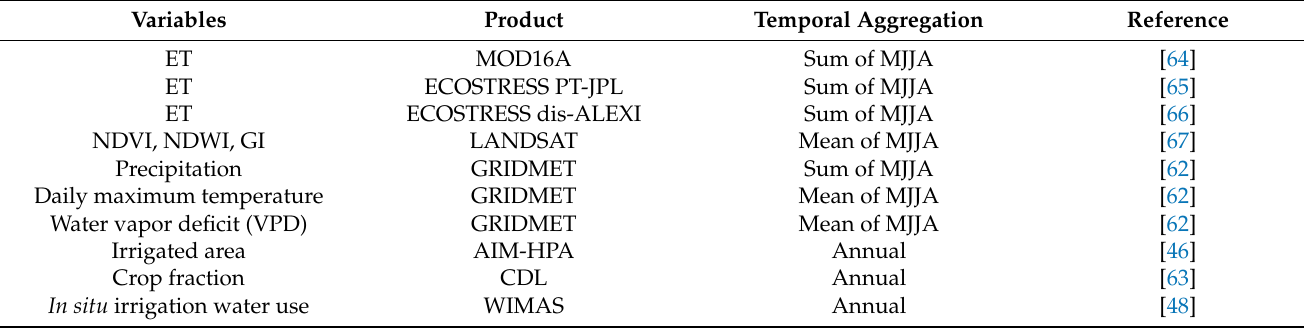
Table 1. Datasets used to generate input and target